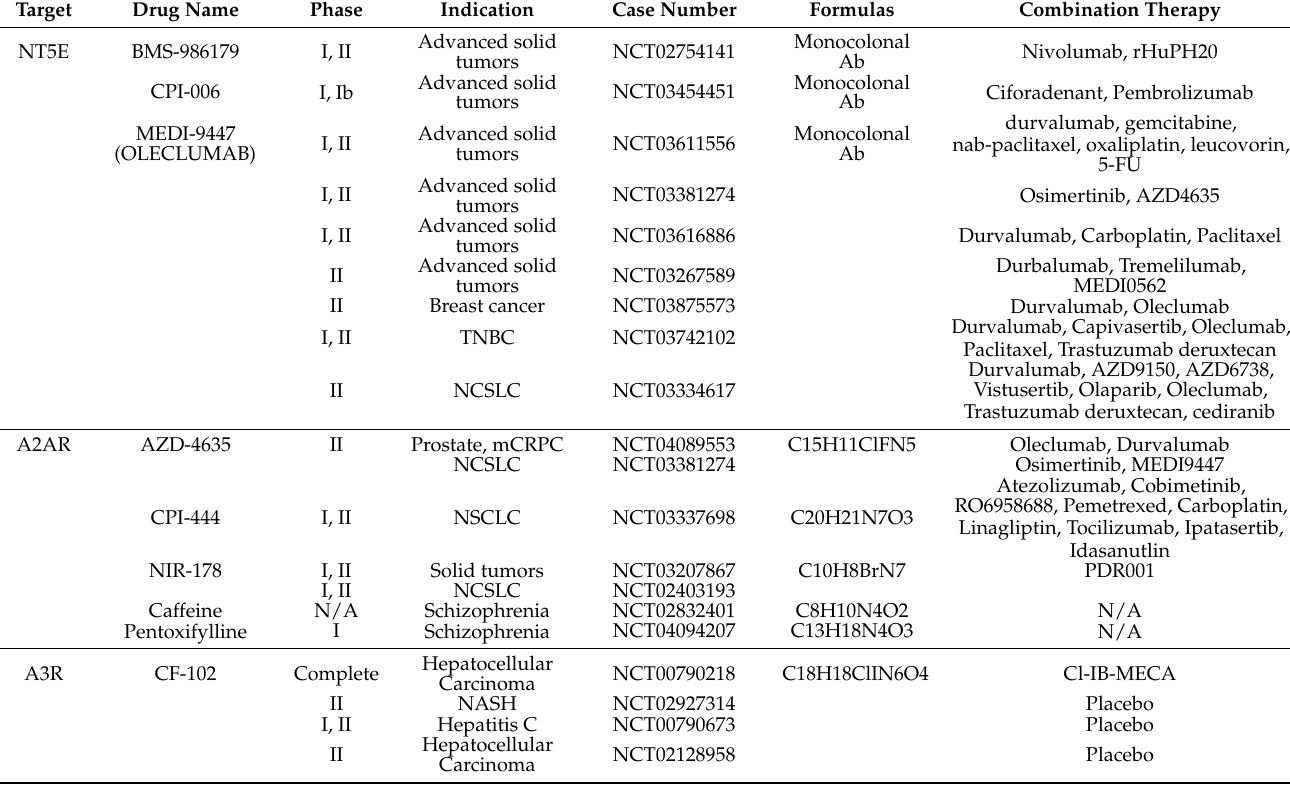
Table 3. Drugs targeting the adenosine system in clinical trials for cancer and